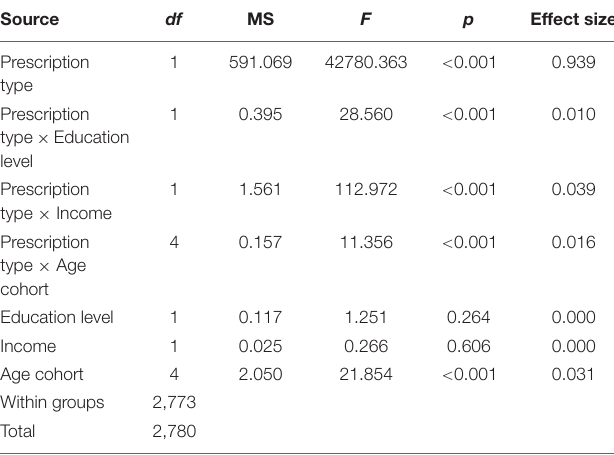
TABLE 4 | GLM ANCOVA summary table for prescription